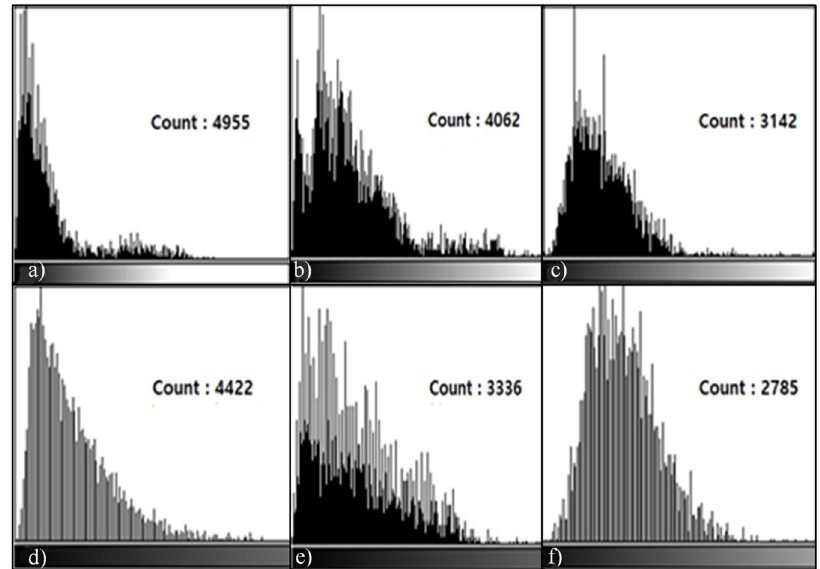
Figure 3. L3, L4 Histogram values measured in the T1 Sagittal Image of Pig L-spine Phantom. When